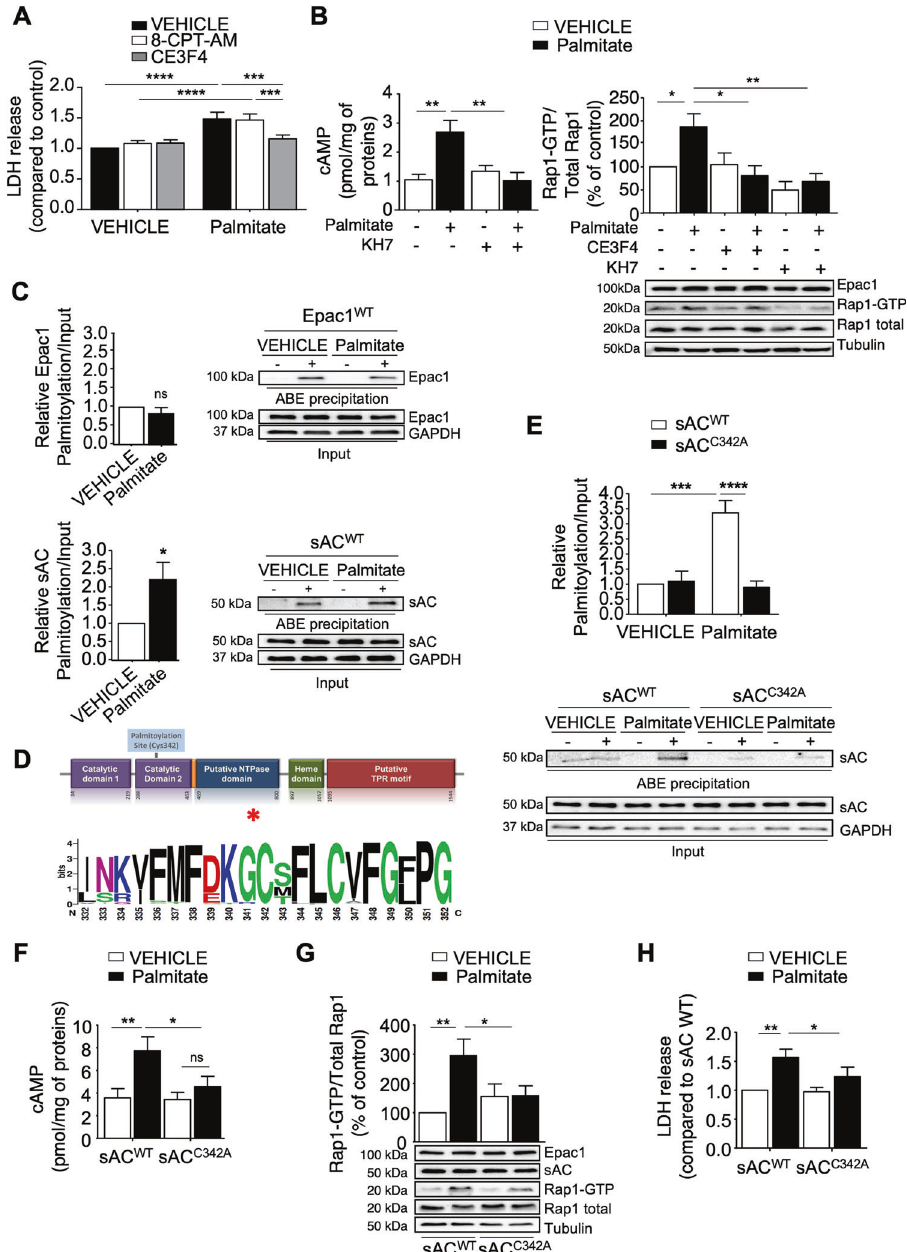
VEHICLE (BSA-control) ( n = 6). B Intracellular cAMP ( n = 6) and Rap1-GTP ( n = 6) levels in cardiomyocytes transfected with Epac1 and pretreated or not with CE3F4 (20 μ M, 30 min) or KH7 (20 μ M, 30 min) before incubation with palmitate (500 μ M, 1 h). C, E Quanti fi cation